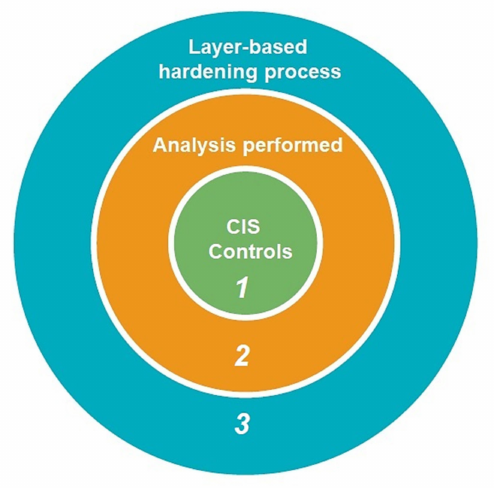
Figure 9. CIS Controls distribution in layer-based hardening